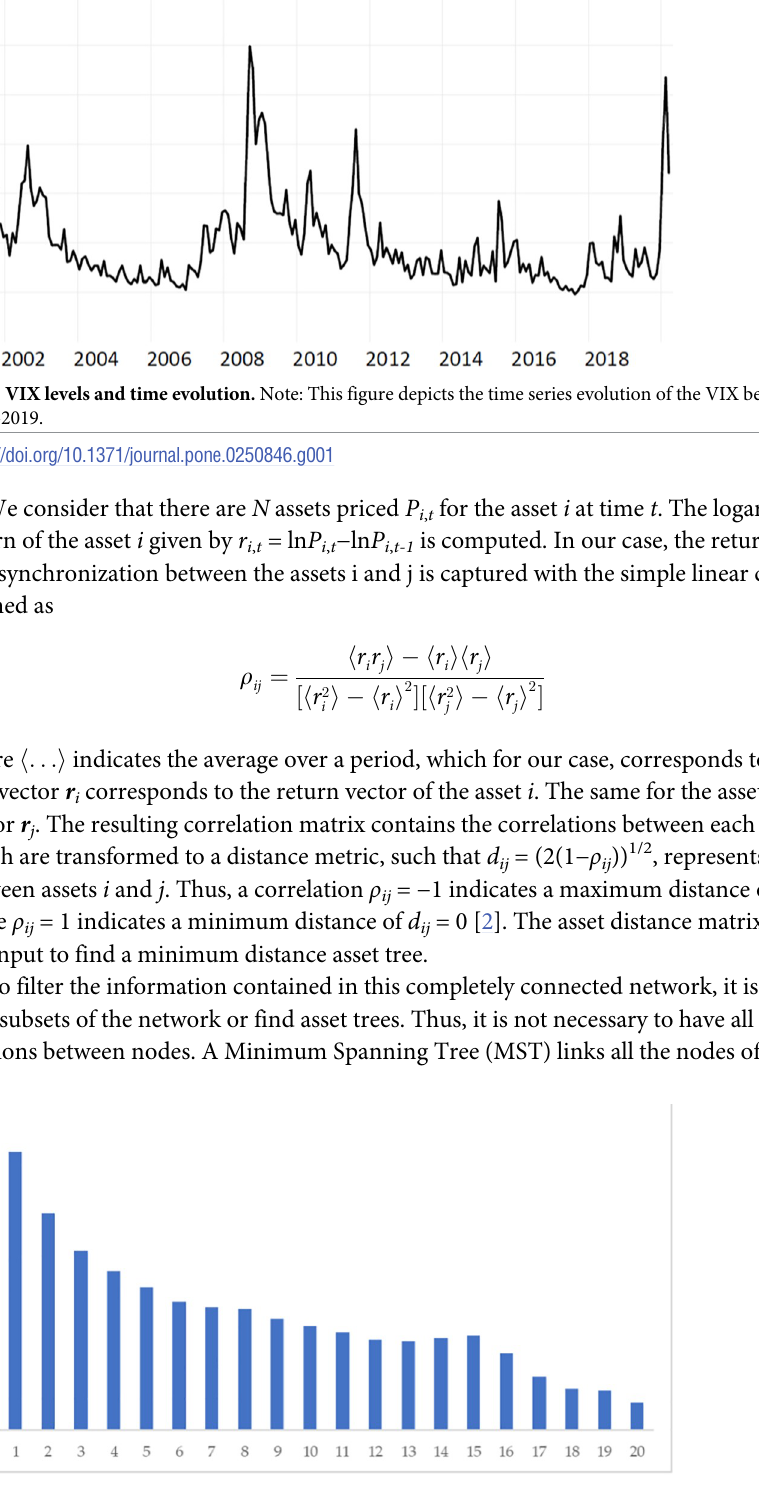
Fig 2. VIX autocorrelation graph. Note: This figure depicts the autocorrelation graph for VIX levels with lags from 1 to 20.